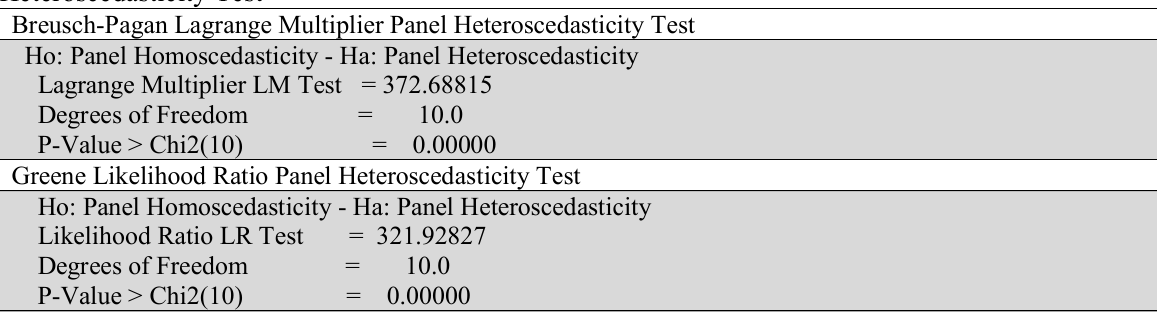
Heteroscedasticity Test